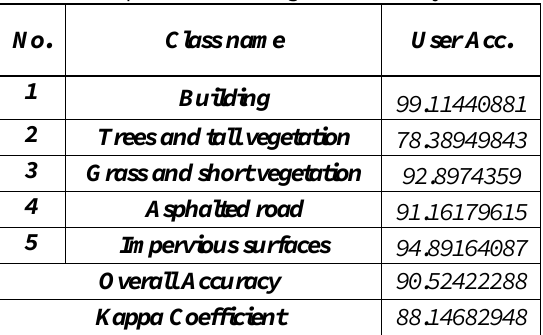
Table 1 - Results of the evaluation criteria for classification accuracy provided by GASVM Orthophoto UAV images of the study area